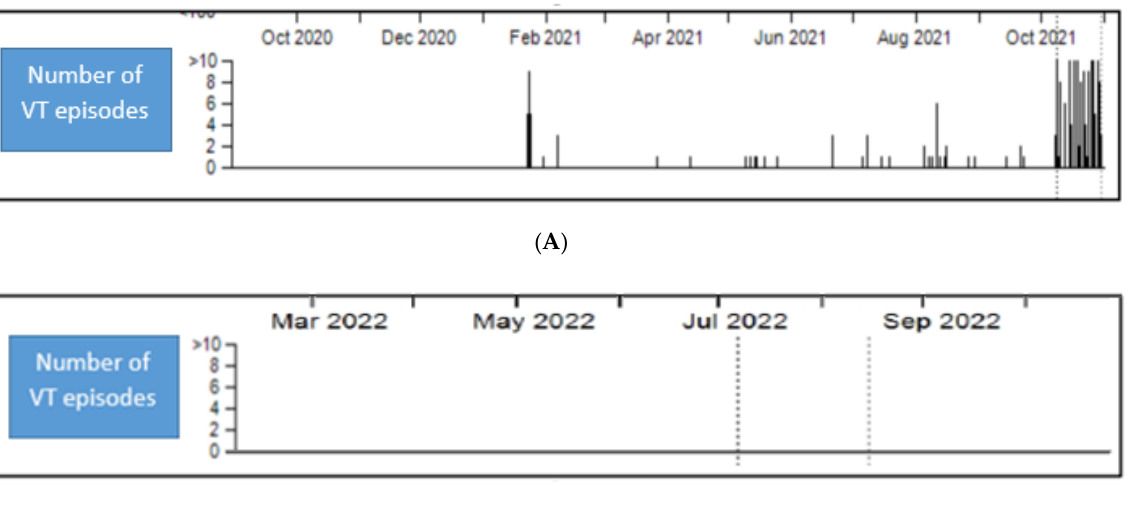
Figure 1. shows the number of ventricular tachycardia episodes recorded by the biventricular cardioverter defibrillator implant. ( A ) number of ventricular tachycardia episodes before SBRT. ( B ) number of ventricular tachycardia episodes after SBRT.